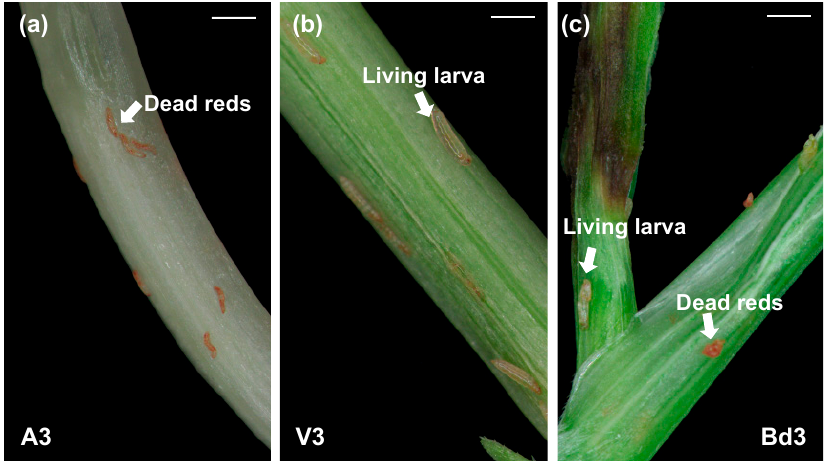
Figure 2. Phenotypic response of host wheat and nonhost Bd plants to Hessian fly larval feeding. ( a ) Biotype L-infested Iris wheat line showing host resistance resulting in avirulent larvae (A3) dying within 3 DAH and appearing as dead reds. ( b ) Biotype L-infested susceptible Newton wheat line with virulent live larvae (V3) in 2nd-instar stage. ( c ) Biotype L-infested Bd harboring both living larvae (2nd-instars) and dead reds (Bd3) by 3 DAH. Scale bars: 500 μ m.